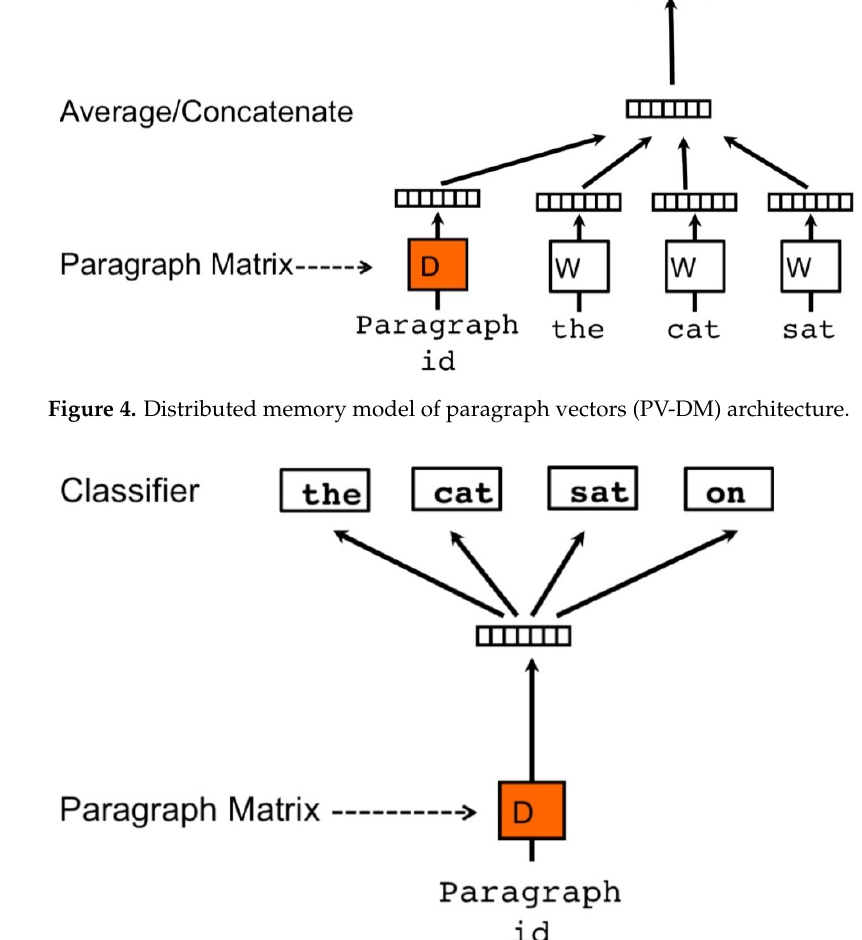
Figure 5. Distributed bag of words model of paragraph vectors (PV ‐ DBOW) architecture.